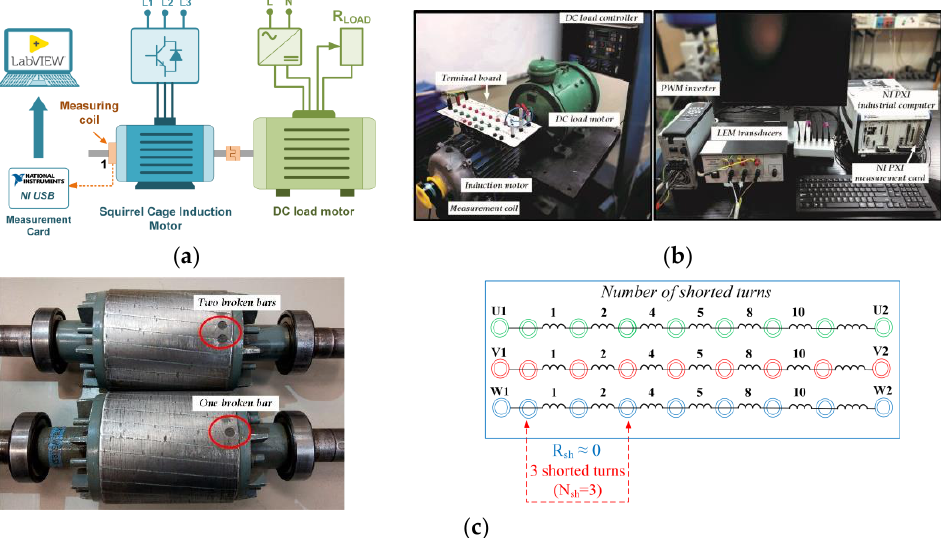
Figure 3. Experimental setup: ( a ) general scheme of the setup; ( b ) components of the real experimental drive system; ( c ) illustration of the physical modeling of the stator and rotor faults, including connection of the stator winding for inter-turn short-circuit modeling and broken bar modeling in a squirrel cage rotor.